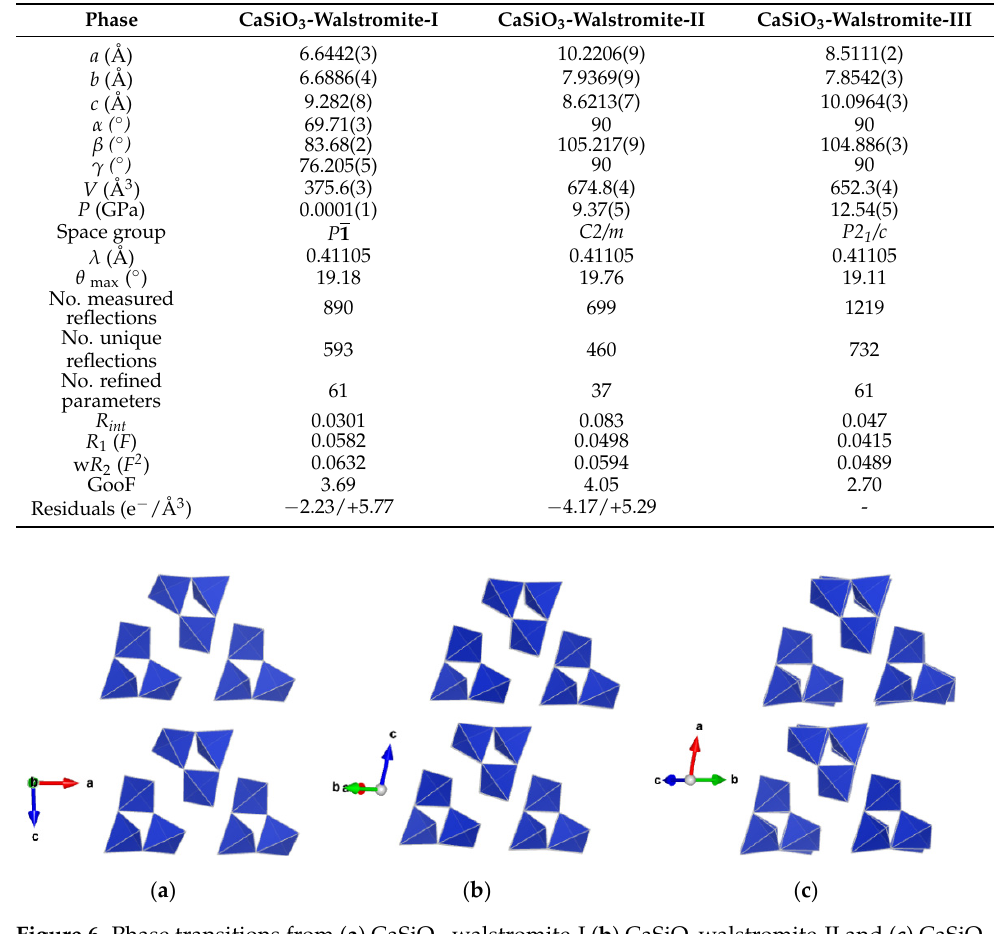
Figure 6. Phase transitions from ( a ) CaSiO 3 -walstromite-I ( b ) CaSiO 3 walstromite-II and ( c ) CaSiO 3 -walstromite-III. The representations of the structure are realized using the program VESTA [17]; a axis is red, the green arrow is the b axis, while the blue arrow is the c axis.